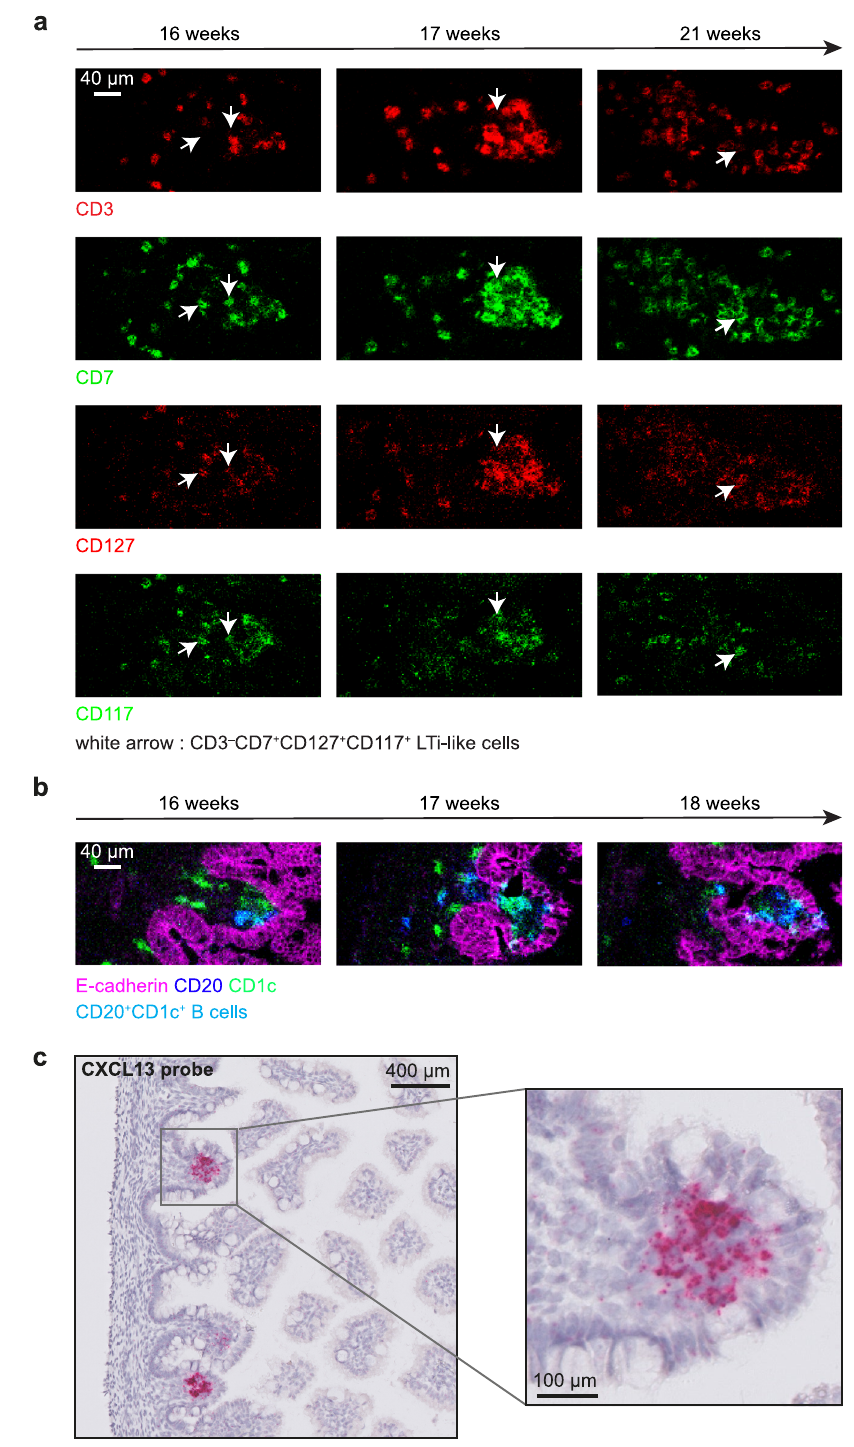
Fig. 6 | The presence of LFs indicators in human fetal intestinal samples. a Visualizationoflymphoidinducercell-likecells(LTi-like:CD3 – CD7 + CD127 + CD117 + ) within LFs. The white arrow indicates the expression of CD7, CD127 and CD117 in the absence of CD3. Scale bar, 40 μ m. b Identi fi cation of CD20 + CD1c + B cells